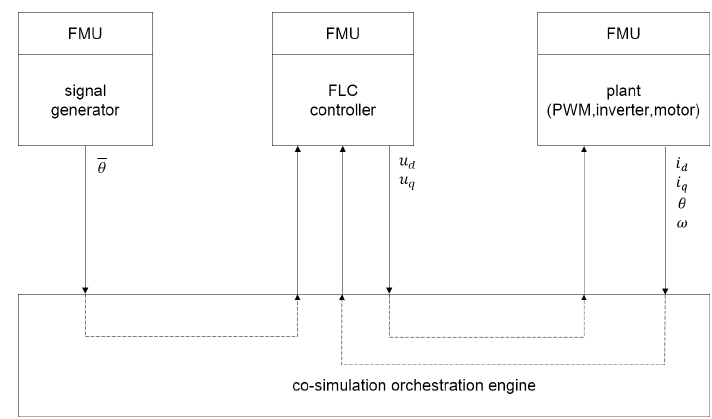
Figure 9. Schematic representation of the FMU connections.